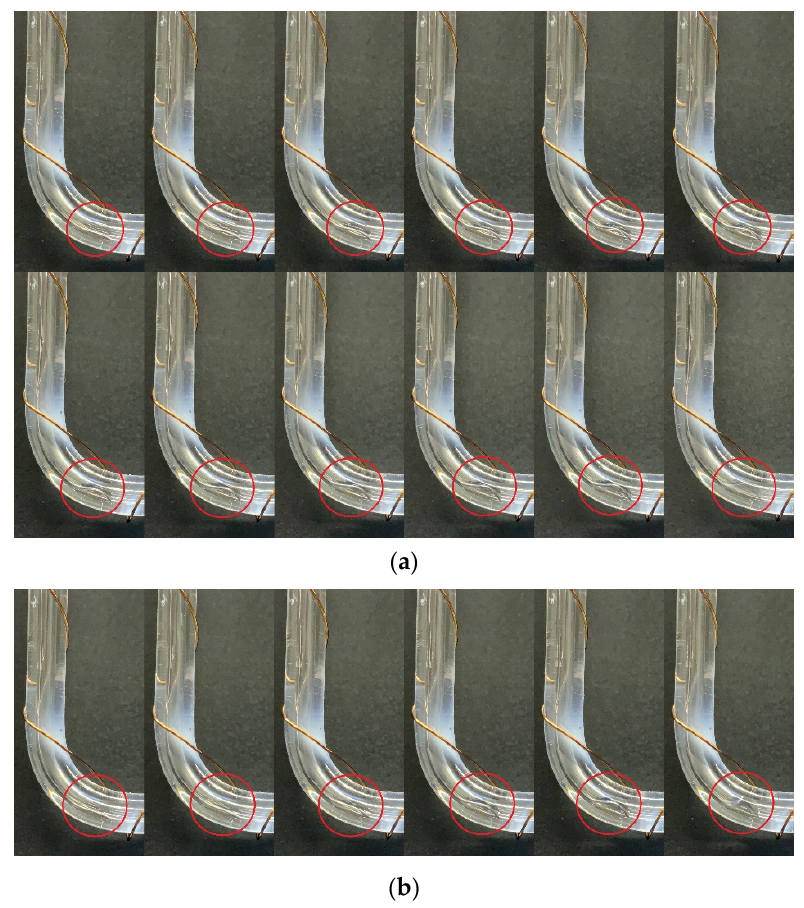
Figure 10. Dynamic photos (shooting time interval: 0.1 s) of bubble generation and rupture in the evaporating section of the PHP under ( a ) vibration-free condition, and ( b ) vibration condition.